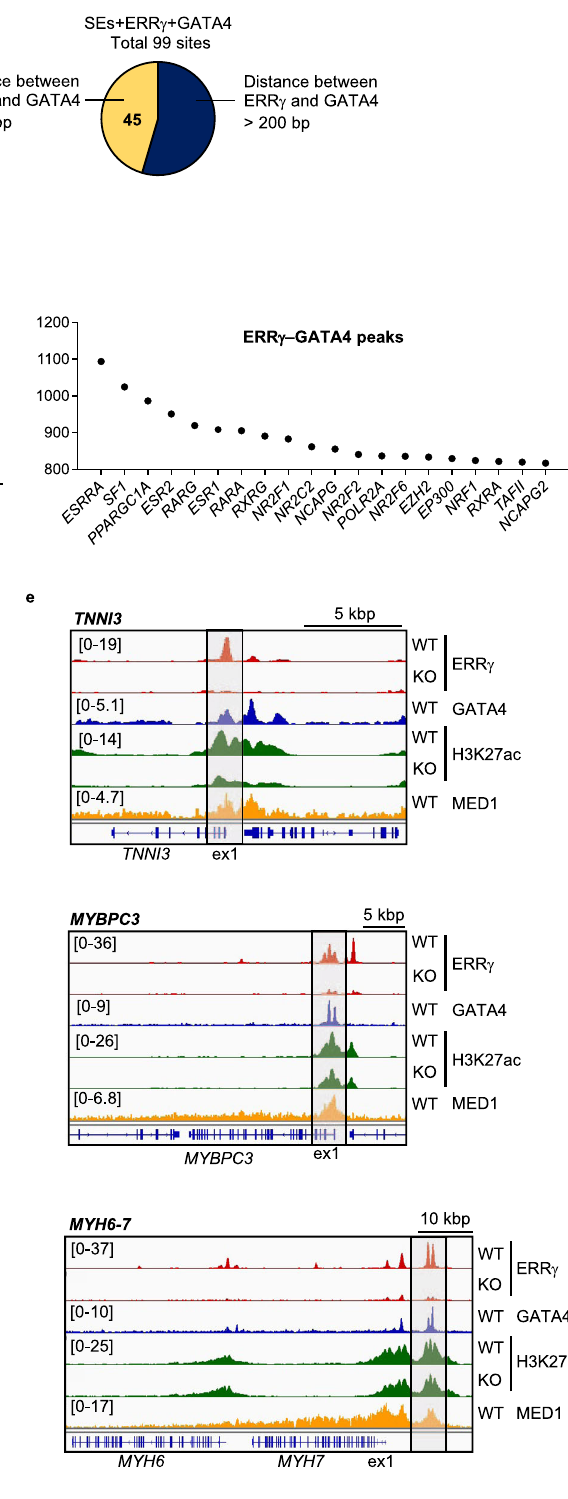
(Fig. 7c). These results indicate that PGC-1 α coactivates ERR- mediated activation of both GATA4-dependent and GATA4- independent genes, and that PGC-1 α is necessary for ERR γ occupation on sites related to GATA-dependent target regulation. To further assess the physical interaction of ERR γ and GATA4, immunoprecipitation (IP) studies were conducted in